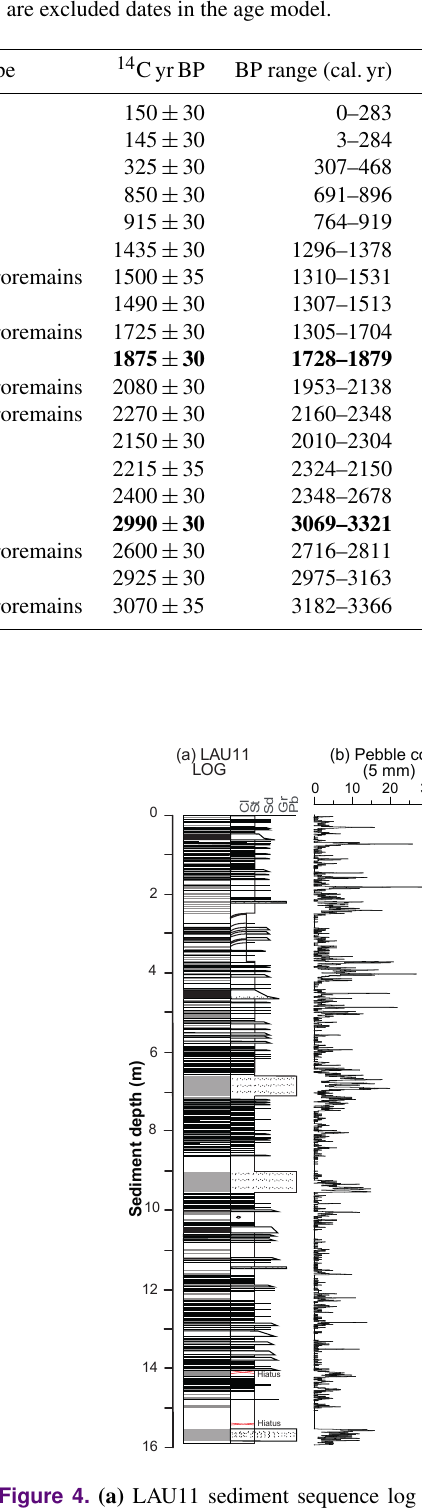
Figure 4. (a) LAU11 sediment sequence log versus (b) the total pebbles counts in function of depth. Each of the three outstanding F1G layer deposits’ thickness identified at depths of 6.35, 8.49 and